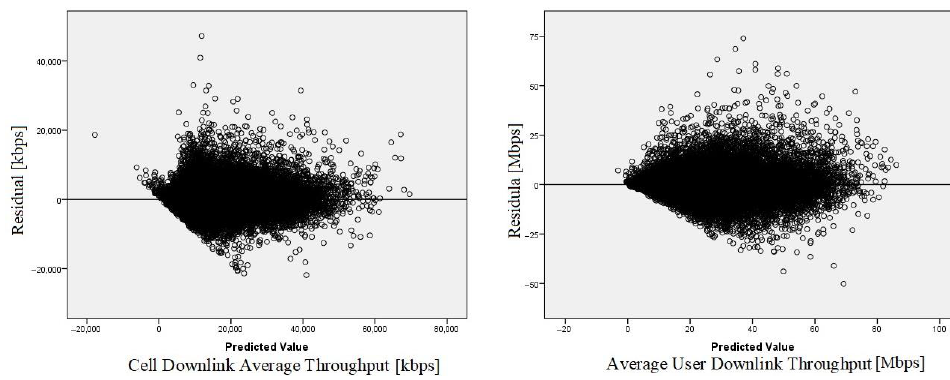
Figure 8. Residual distribution graph for two output variables in MLP prediction model.